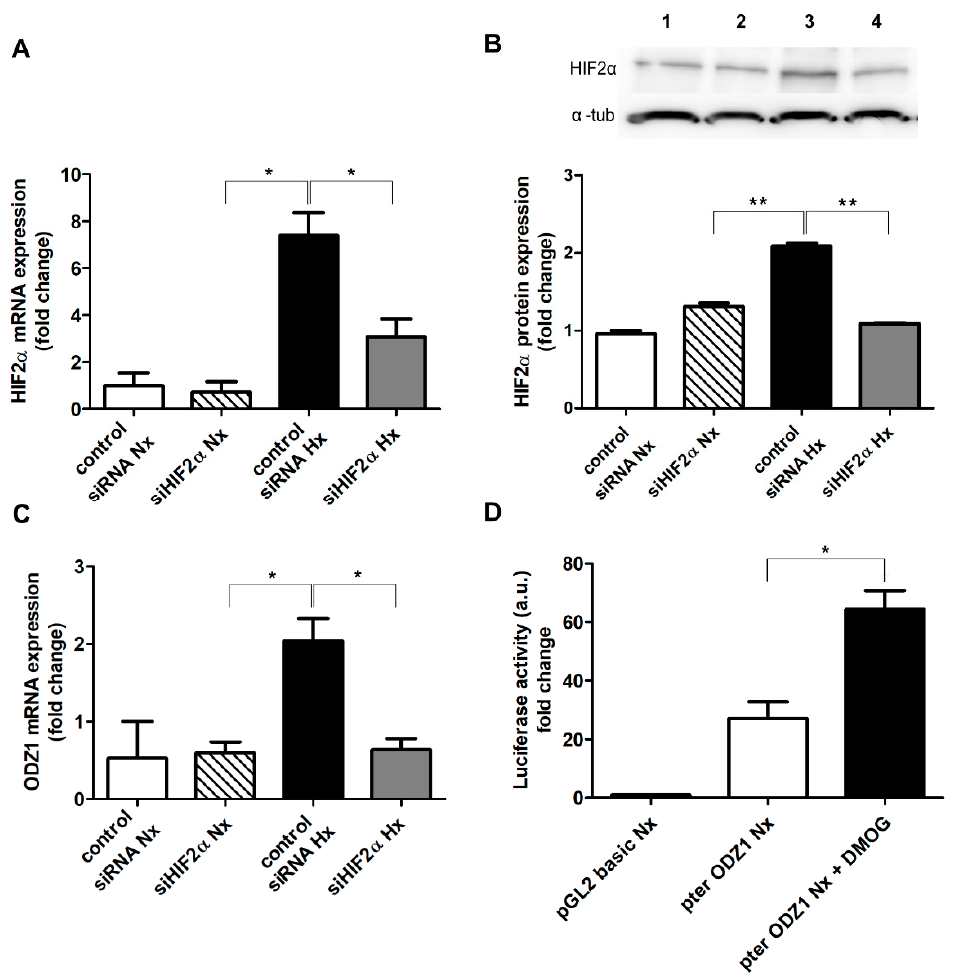
Figure 4. Knockdown of HIF2 α decreased the expression of ODZ1. ( A , B ) GSCs were transfected with siHIF2 α or siRNA control and cultured in normoxia (Nx, 21% O 2 ) or hypoxia (Hx, 1% O 2 ) for 48 h. The expression of HIF2 α at the mRNA ( A ) and protein ( B ) level was analyzed. 1: negative control siRNA in normoxia; 2: siHIF2 α in normoxia; 3: negative control siRNA in hypoxia; 4: siHIF2 α in hypoxia. Data were normalized to G6PD levels (mRNA) and α -tubulin (protein). * p < 0.05, ** p < 0.01. ( C ) Under the same experimental conditions, the mRNA levels of ODZ1 were also quantitated by qPCR. ( D ) GSCs were transfected with ODZ1 promoter cloned into a luciferase reporter plasmid and luciferase activity was analyzed after 48 h in the presence or in the absence of DMOG under normoxia. pGL2: empty plasmid (control). * p < 0.05. Bars represent the mean ± SEM of three independent experiments.